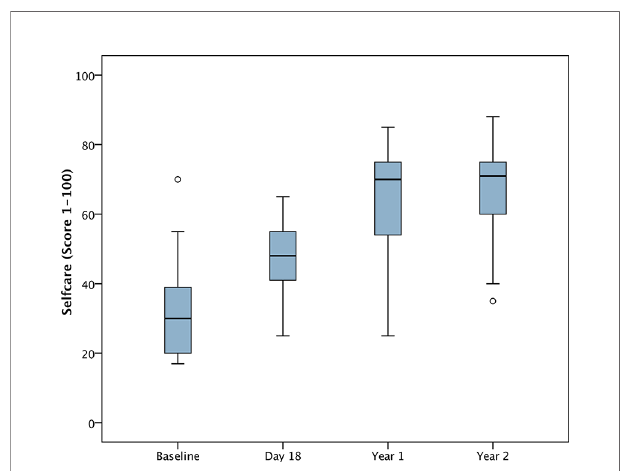
FIGURE 1 | Box plot: DD-C-GAS Self-care (N = 25). Non-parametric repeated measures ANOVA (Friedman test): p = 0.000***. Pairwise comparisons between time points (Wilcoxon signed rank test): p-values adjusted by Bonferroni-Holm were 0.000***, except for comparison Year 1 to Year 2 (p = 0.060).